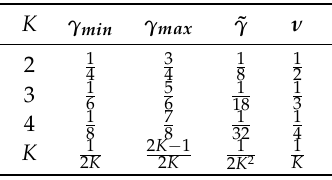
Table 3. The performance comparison under different K